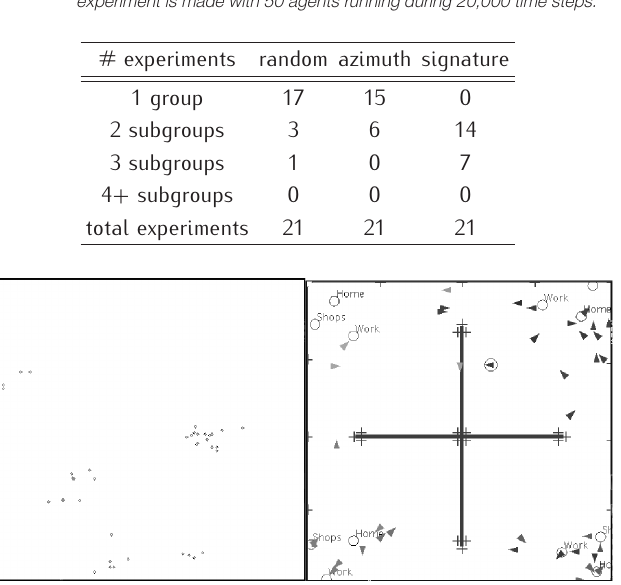
Table 1. Influence of the imitation strategy on the formation of subgroups (2 villages). We report here the number of experiments that led to the emergence of 1, 2 or 3 subgroups, when imitation is random, based on the azimuth (left column) or on the signature (right column). Each experiment is made with 50 agents running during 20,000 time steps.